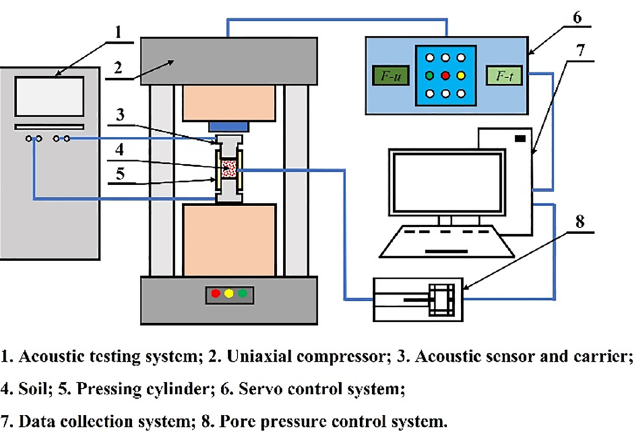
Figure 6. The schematic diagram of the experimental system.